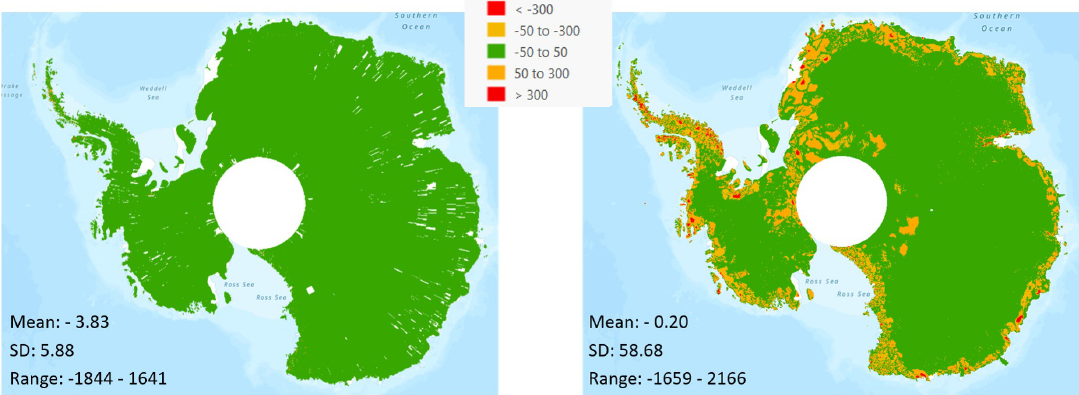
Figure 15. Di ff erences from WorldDEM for REMA ( a ) and RAMP ( b ).